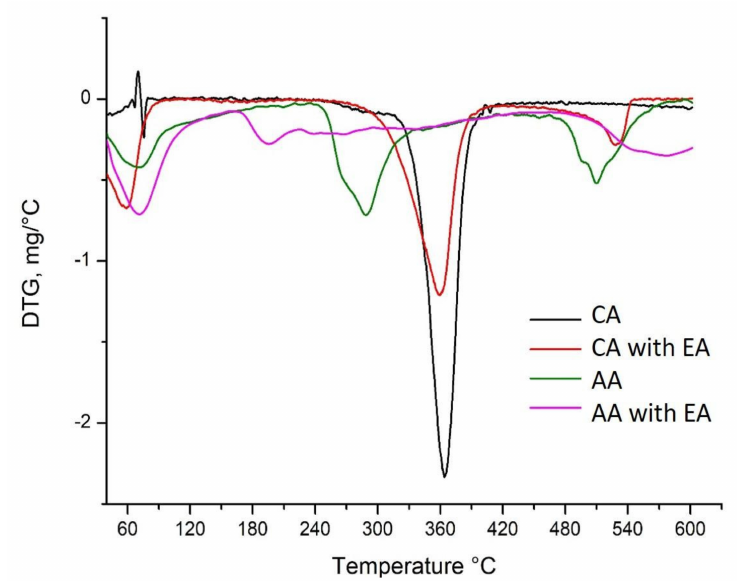
Figure 7. Thermogravimetric derivative (DTG) of AA and CA films, with and without anthocyanin extract